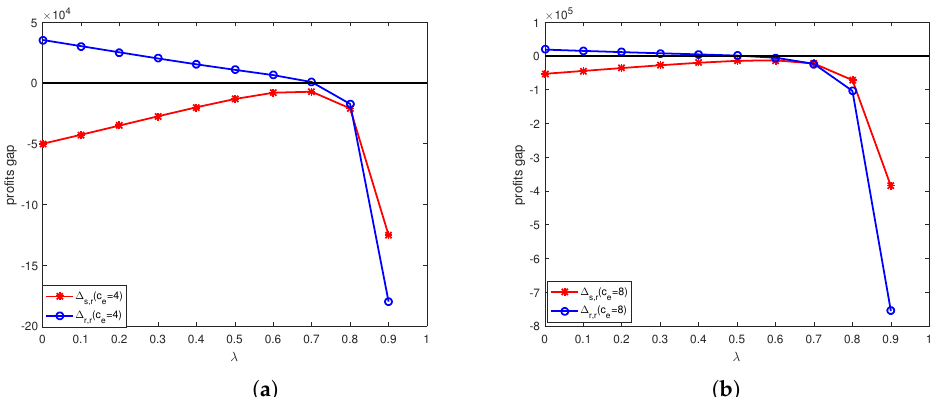
Figure 8. The profit gap before and after offline channel price discount contracts under different unit price of carbon trade: ( a ) c e = 4. ( b ) c e = 8.